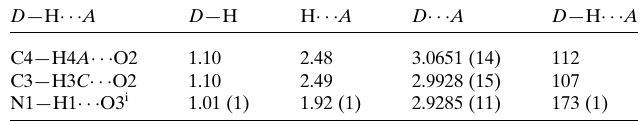
Table 1 Hydrogen-bond geometry (A˚ , (cid:5) ).